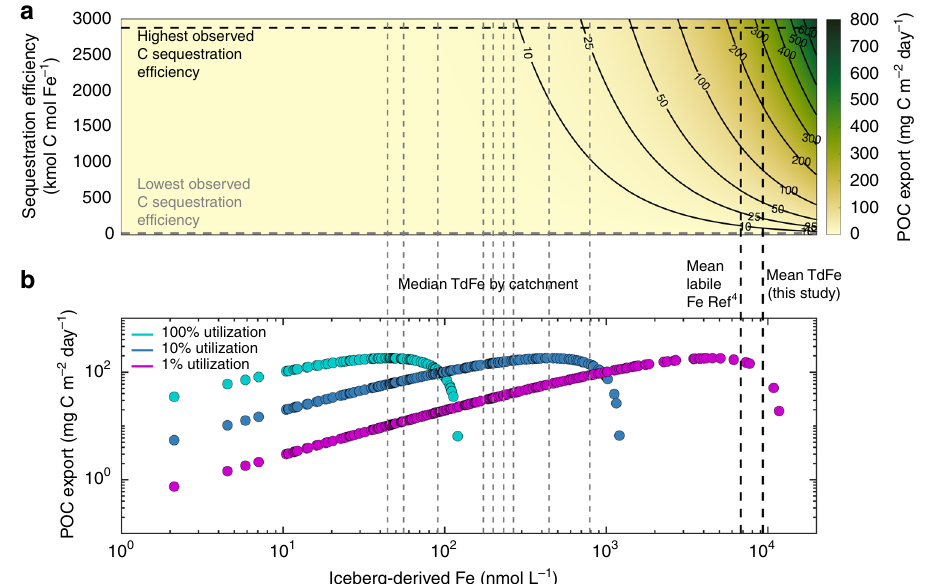
Fig. 3 Estimating C export fl uxes. Following fertilization of Fe-limited waters for a regional 0.1% meltwater enrichment, C export is estimated using two different methods. a Fe-to-C sequestration ef fi ciencies estimate the organic C fl ux to > 100 m depth following Fe fertilization. Vertical lines correspond to the median TdFe of ice each catchment (gray dashed lines), mean labile Fe derived from estimates of iceberg sediment content and mean TdFe for this dataset (black dashed lines). b POC export is estimated for 1, 10 and 100% Fe utilization (the percentage of Fe supply up-taken by biota) scenarios. This Fe supply is combined with Fe:C cellular ratios and the observed trend between surface primary production and C export ef fi ciency in the Southern Ocean 74 . Each dot corresponds to a measured iceberg TdFe